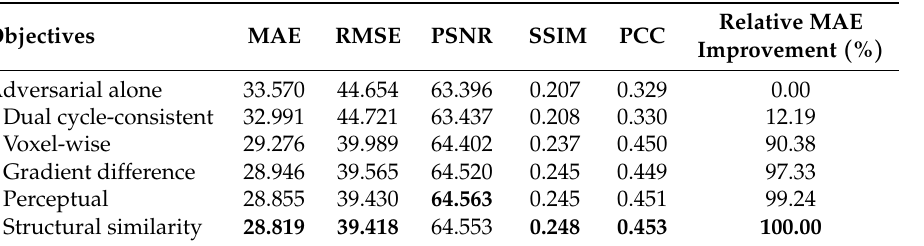
Table 9. Ablation analysis of the objective function. The results represent the average of five trials. The best scores are displayed in bold.